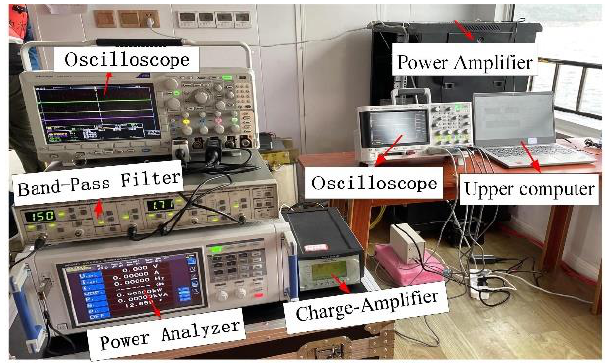
Figure 13. Underwater acoustic measurement system.